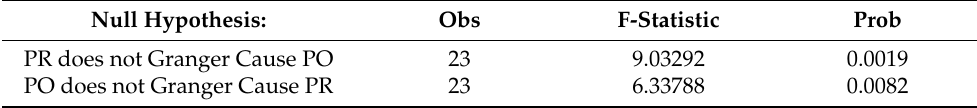
Table 4. Results of Pairwise Granger Causality